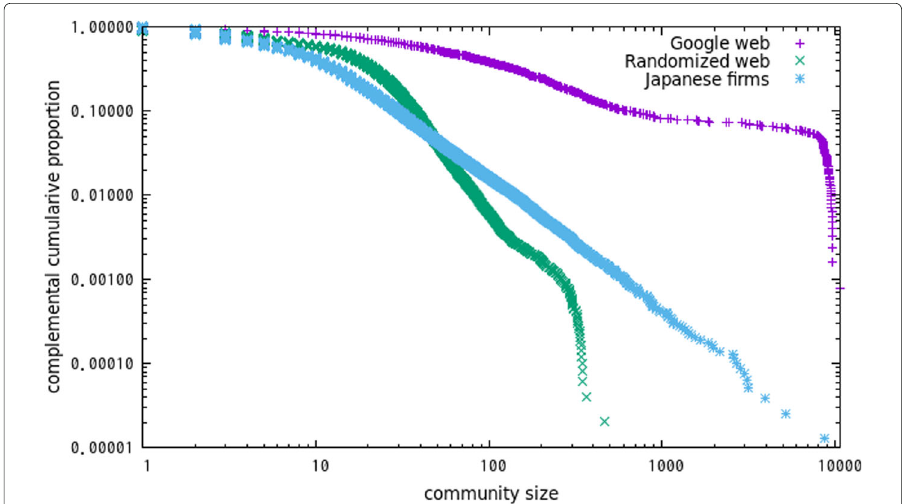
Fig. 11 community size distributions of Google web network (with purple “+” marks), Google web randomized link (with green “x” marks), and Japanese production network (with cyan “*”